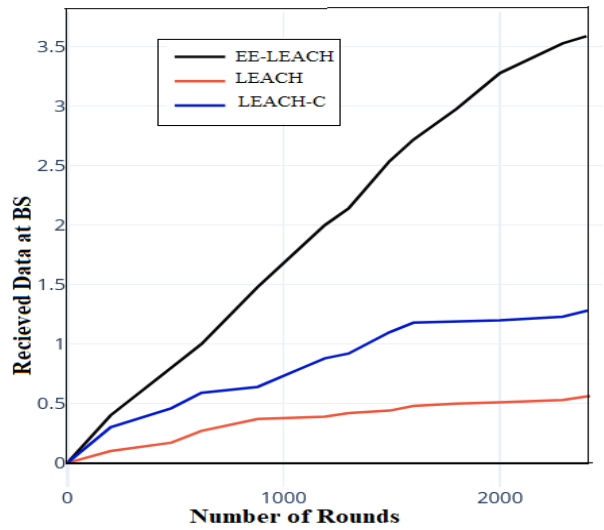
Figure 10. Delivery Success.